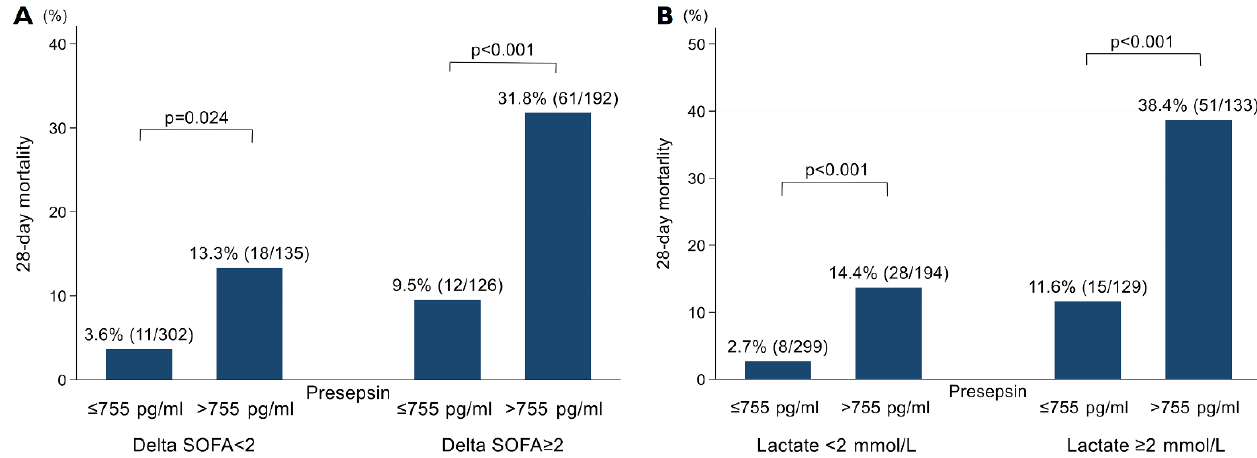
Figure 3. Comparison of 28-day mortality according to the level of presepsin based on ( A ) delta sofa score and ( B ) lactate value, respectively. SOFA, Sequential Organ Failure Assessment.